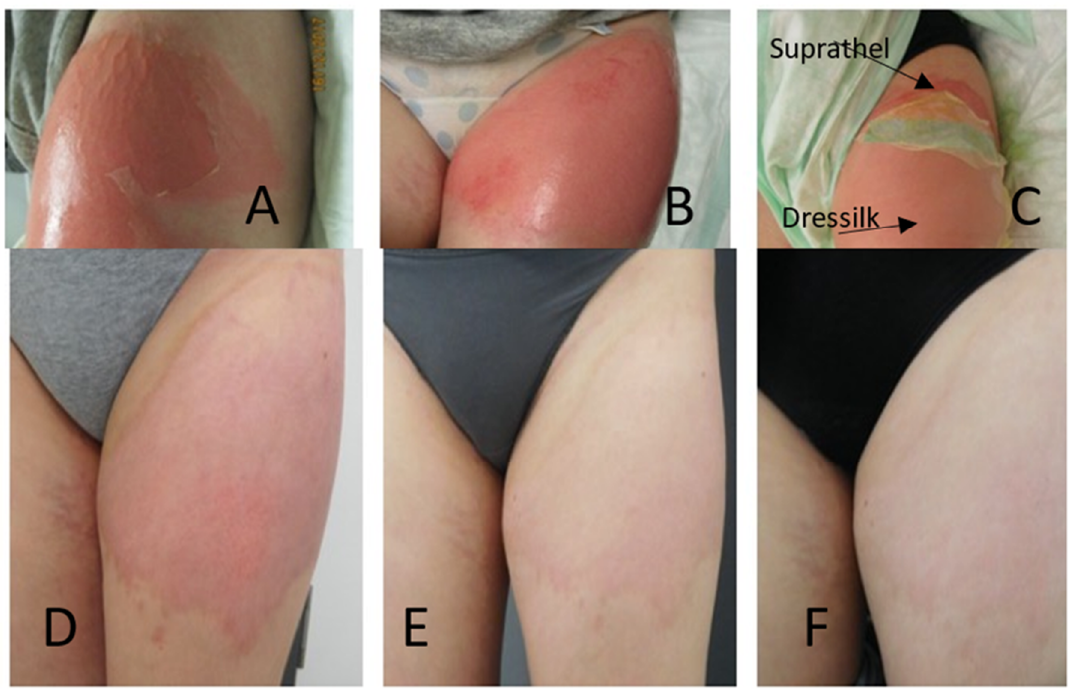
Figure 2. Partial thickness burn of the left leg; ( A , B ) before and after debridement; ( C ) application of Dressilk and Suprathel; ( D ) 3-month follow-up; ( E ) 6-month follow-up; ( F ) 12-month follow up. Subjective scar assessment was performed using the Vancouver Scar Scale (VSS).